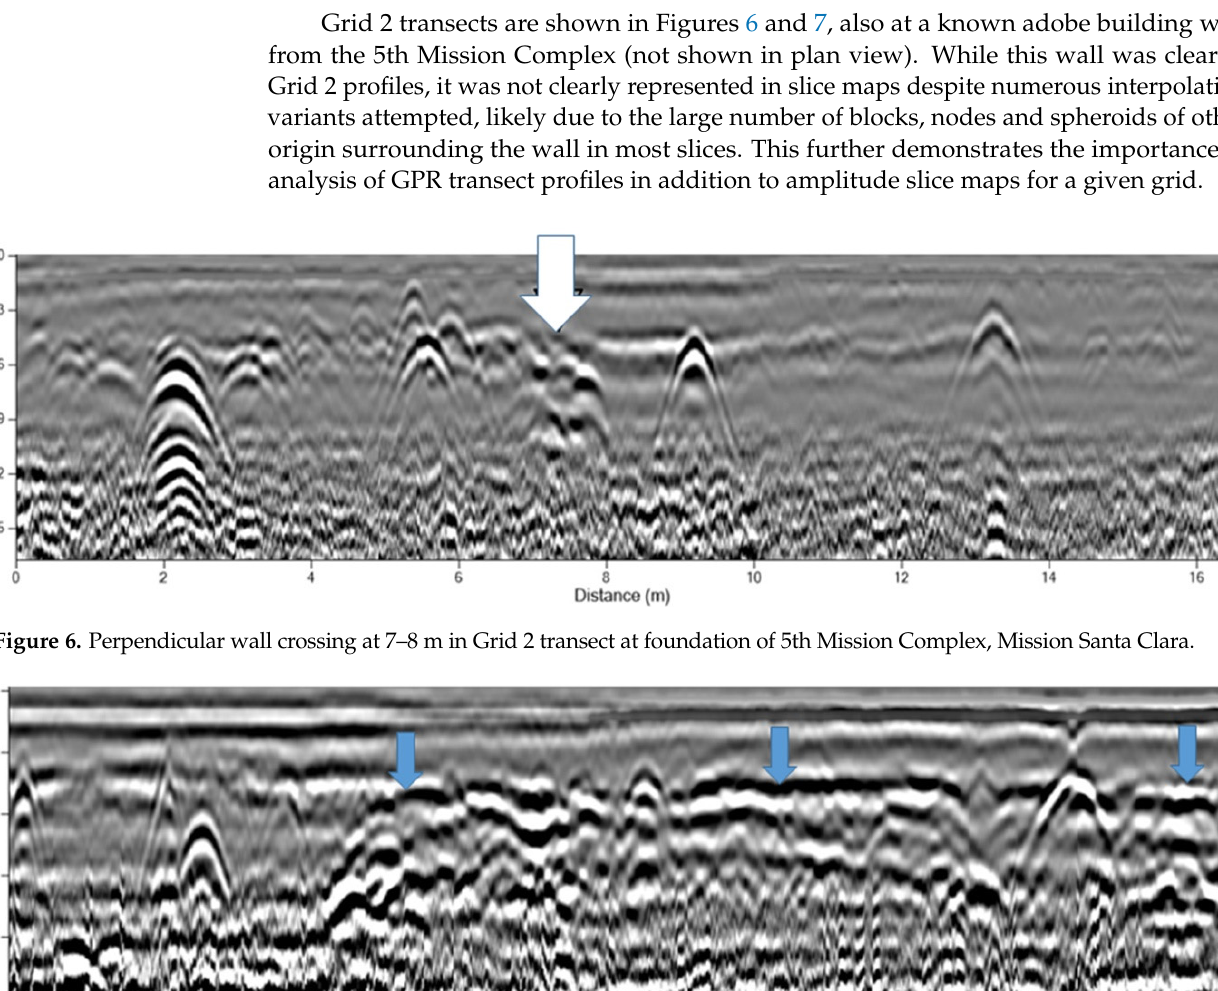
Figure 5. Possible builders’ trenches on both sides of the east wall (thick white arrow) at Mission Santa Clara seen as gaps (thinner black arrows) in horizontal strata to left and right in transect using the 400 MHz antenna.